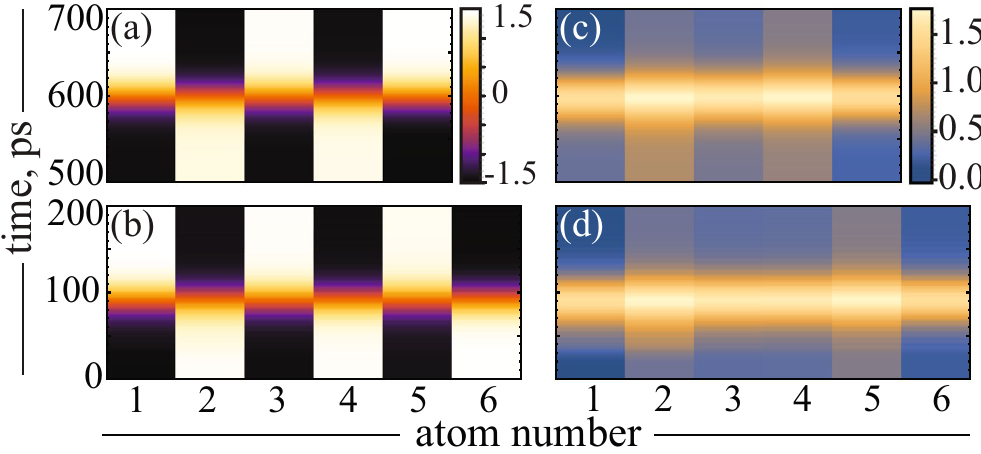
Figure 3. Time evolution of < S z > spin components [( a ) and ( b )] and the calculated single-particle Von Neumann entropies [( c ) and ( d )] for the 5- and ( b ) 6-atomic chains,